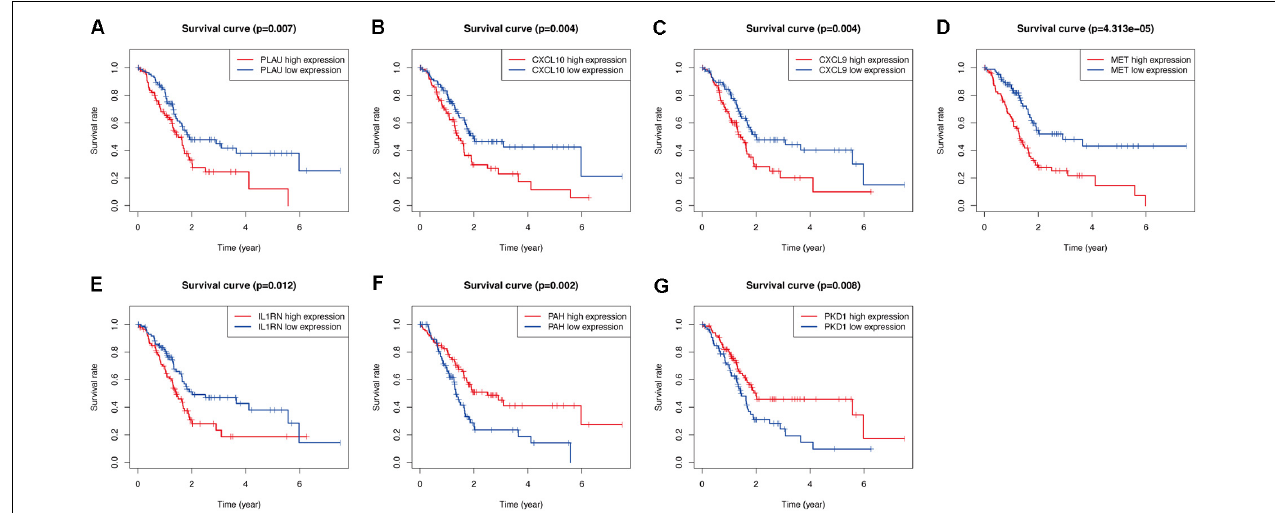
FIGURE 10 | Validation the prognostic value of the prognosis-related OS genes of PLAU (A) , CXCL10 (B) , CXCL9 (C) , MET (D) , IL1RN (E) , PAH (F) , and PKD1 (G) in TCGA-PC cohort by Kaplan-Meier analysis.